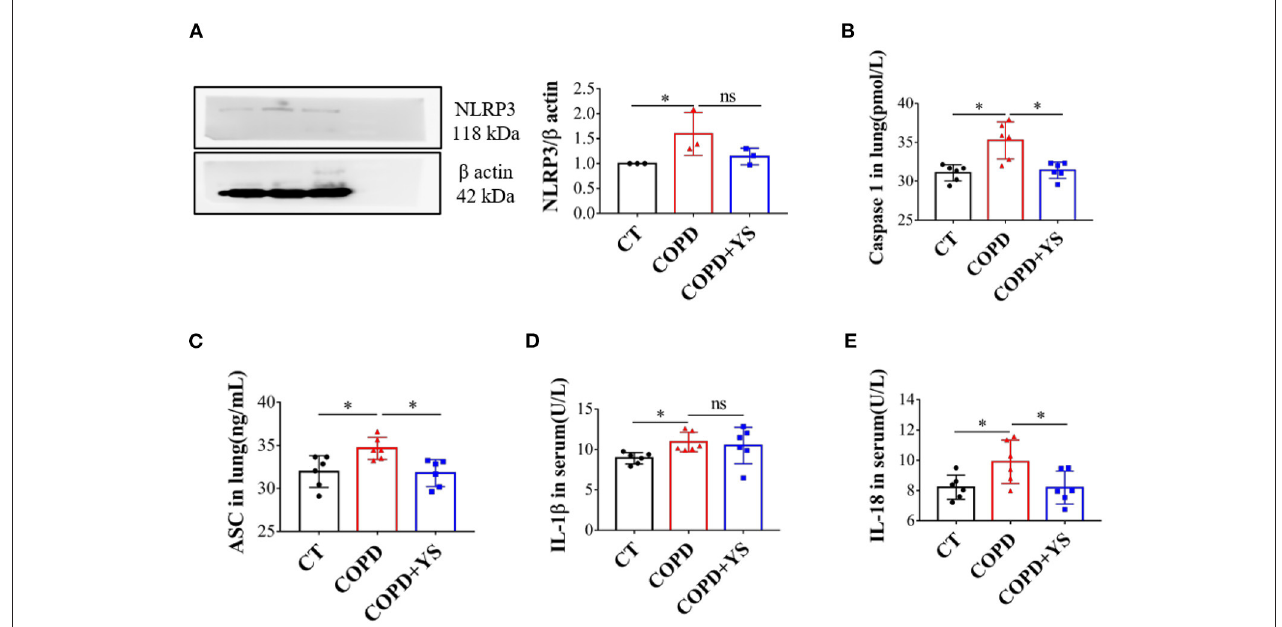
FIGURE 6 | (A) NLRP3 in the lung of CT, COPD, and COPD + YS ( n = 3). (B) Caspase1 in the lung of CT, COPD, and COPD + YS ( n = 6). (C) ASC in the lung of CT, COPD, and COPD + YS ( n = 6). (D) IL-1 β in the serum of CT, COPD, and COPD + YS ( n = 6). (E) IL-18 in the serum of CT, COPD, and COPD + YS ( n = 6). The data are presented as the means ± SEM of three experiments (ns, non-significant, * P < 0.05).